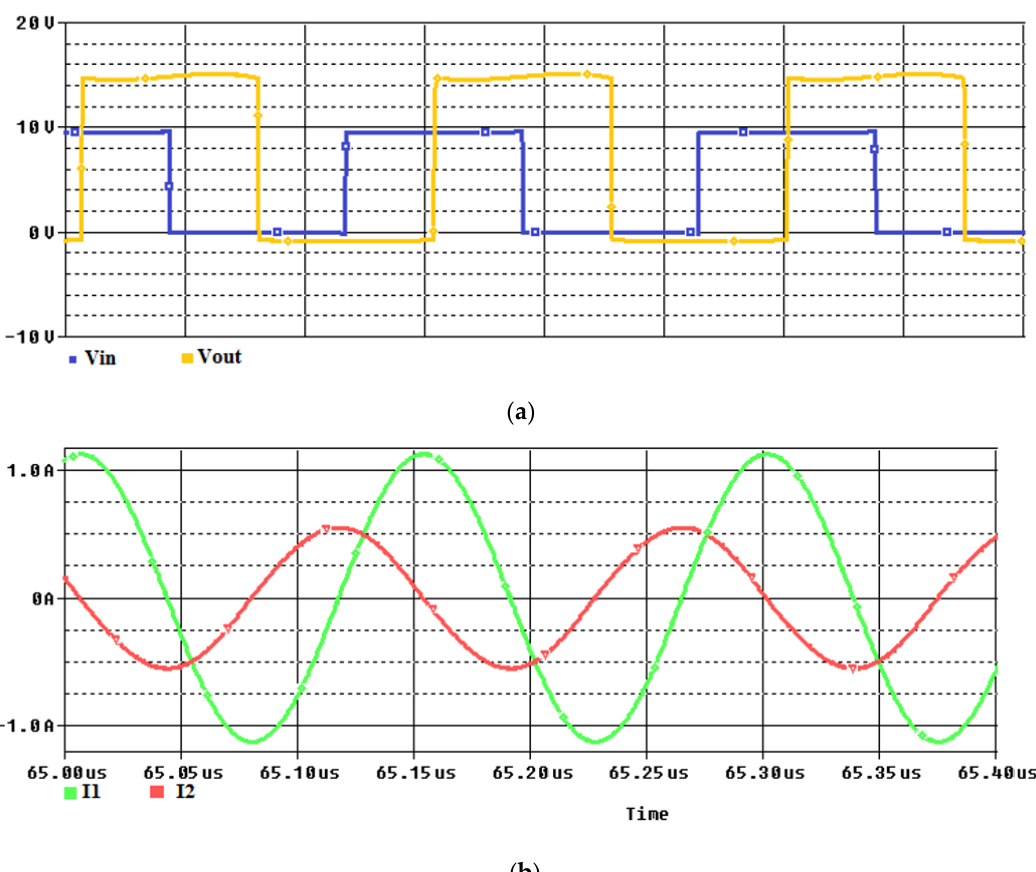
Figure 13. Waveforms of ( a ) input and output voltages and ( b ) coil currents.